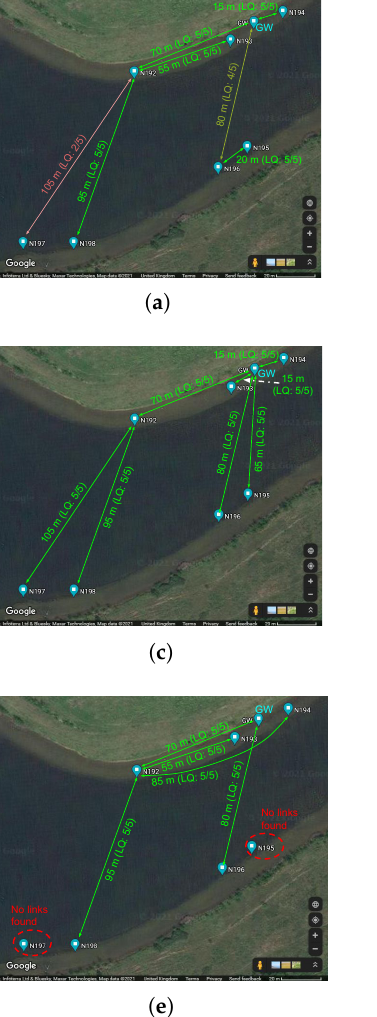
Figure 12. Self-organized network topologies from the Heslington East lake trials, established via the proposed network discovery protocol. ( a ) Topology 1; ( b ) Topology 2; ( c ) Topology 3; ( d ) Topology 4; ( e ) Topology 5 (node outage for N195, N197); ( f ) Topology